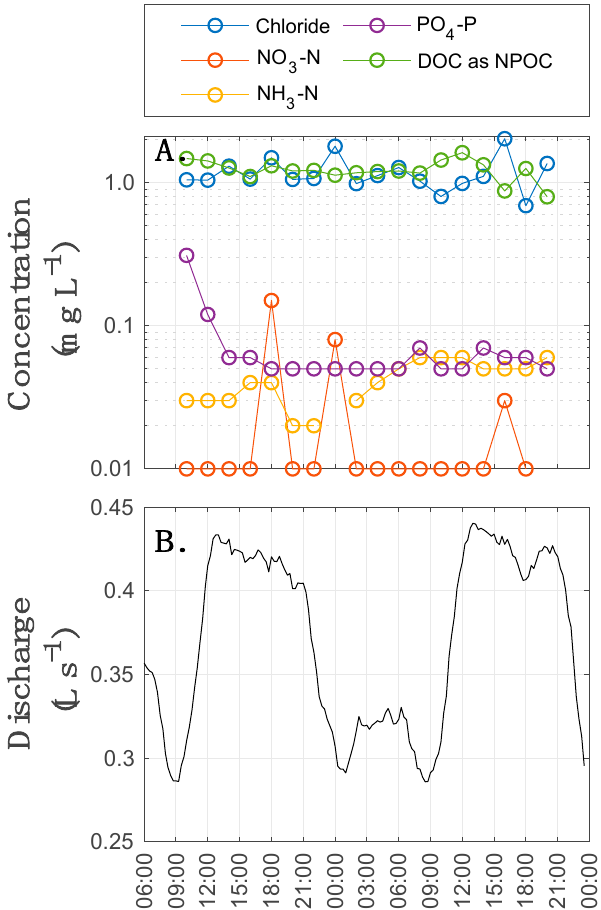
Figure 5. ( A ) Time series of nutrients and anions in the stream during diurnal fluctuations; ( B ) discharge during data collection.